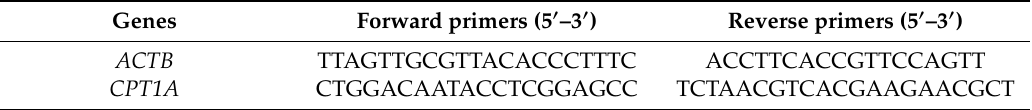
Table 1. Sequence of primers used in real-time polymerase chain reaction.